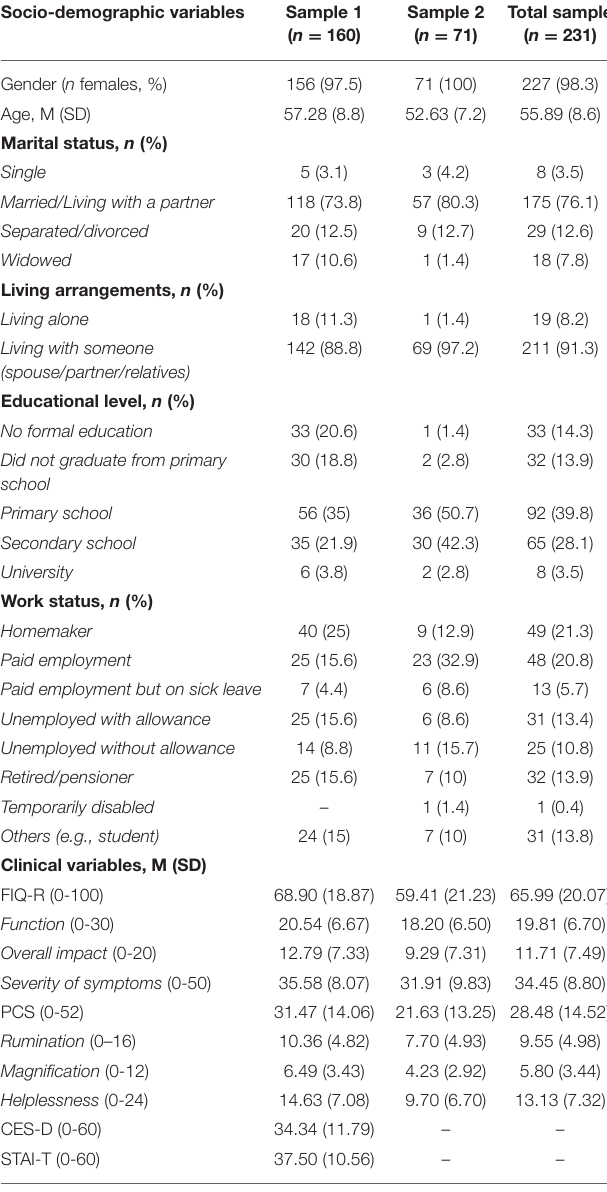
TABLE 1 | Participant Characteristics for the Two Samples and the Entire